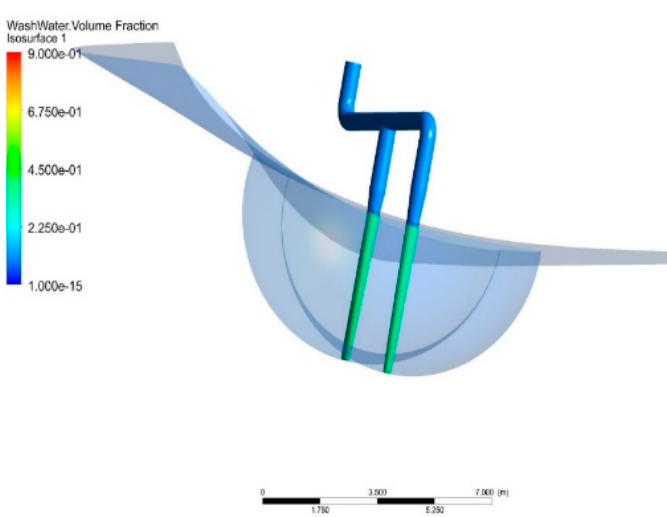
Figure 16. Scrubber Wash Water Volume Fraction of 0.4 isosurface development.